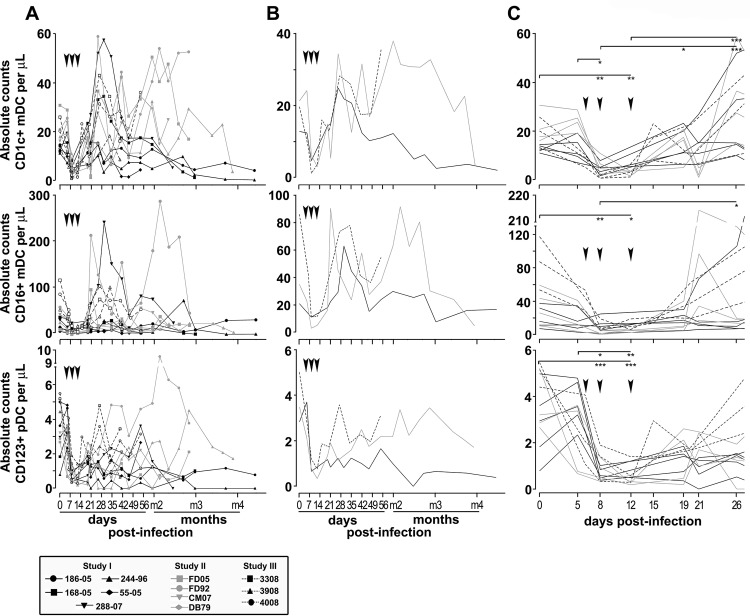
Longitudinal assessment of myeloid and plasmacytoid DCs in whole blood of SIV-infected CD8-lymphocyte depleted rhesus macaques.The absolute cell counts of CD1c+ mDCs (upper row panels), CD16+ mDCs (middle row panels) and CD123+ pDCs (lower row panels) determined over the course of infection are shown. Three independent studies are shown: study I (black symbols and lines; n = 5), study II (grey symbols and lines; n = 4) and study III (black symbols and dotted lines; n = 3). Black arrowheads indicate time of administration of anti-CD8 depleting antibody. A. Absolute DC numbers from individual animals throughout infection. B. Averages of absolute DC numbers throughout infection. C. Individual absolute DC numbers measured in early disease i.e. from pre-infection to 26 dpi including acute (8 dpi) and post-acute phases are shown to emphasize differences between changes in CD1c+ and CD16+ mDC counts. The Kruskal-Wallis test followed by Dunn’s post test was used to determine the significance (asterisks) of differences in absolute numbers during early SIV infection. * P<0.05, ** P<0.01, *** P<0.001. Box shows symbols for individuals animals.